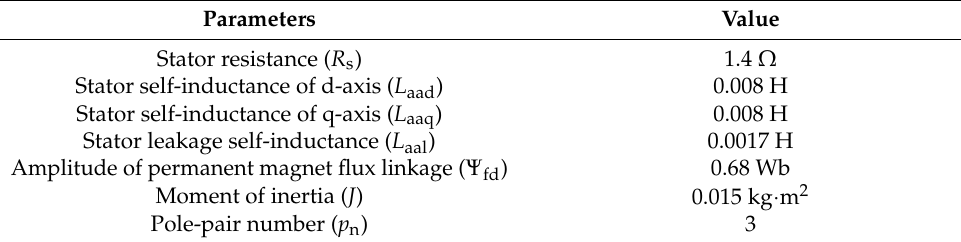
Table 2. Parameters of the dual three-phase PMSM.